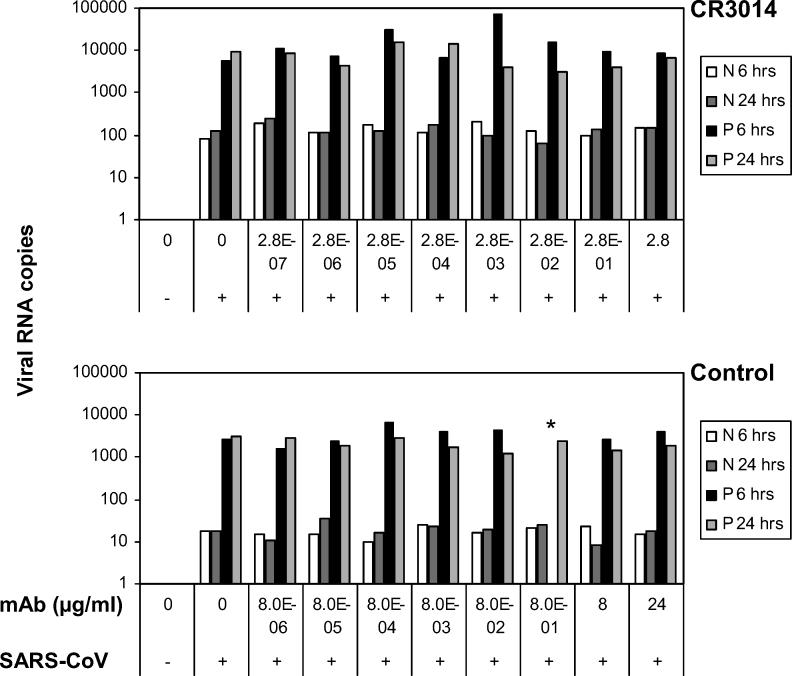
Infection of Differentiated Human Macrophages with SARS-CoV (HKU-39849) in the Presence of CR3014 or a Control mAbOne representative experiment of three independent experiments is shown. Total RNA was extracted at 6 and 24 hours postinfection, and the copy number of positive (P) and negative (N) strand RNA of SARS-CoV
ORF1b was determined by real-time quantitative RT-PCR and normalized for the levels of
β-actin mRNA. The bars represent mean of duplicate viral load titrations. In the control experiment, * indicates an aberrant result.